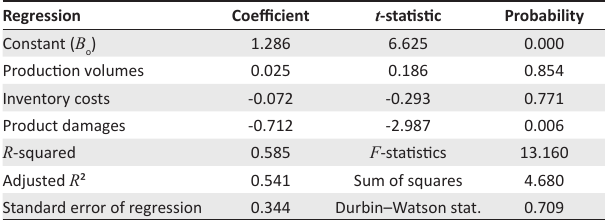
TABLE 3: Inventory control results relating to production volumes, inventory costs and product damages. Regression